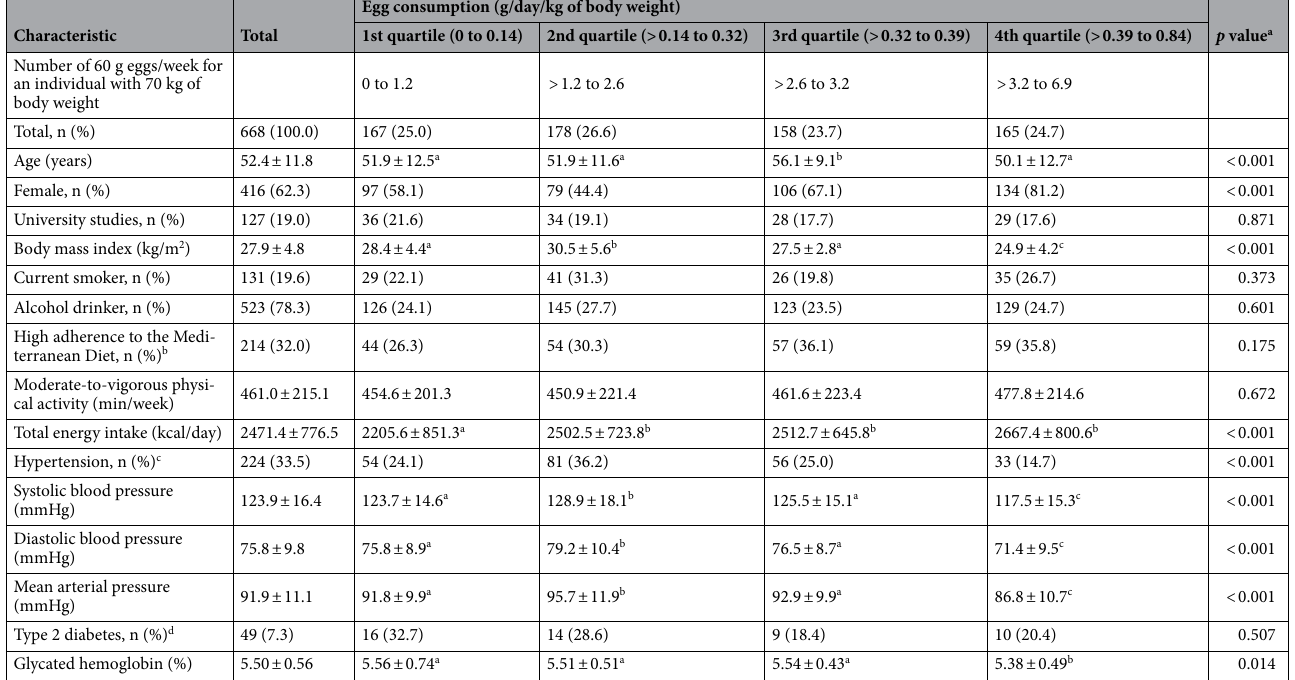
Table 1. Characteristics of the study participants by the number of eggs consumed per week per kg of body weight. Values are means ± standard deviations, except when indicated “n (%)”. a Chi-squared test for categorical variables and ANOVA for continuous variables. Different letters indicate significant differences between quartiles of egg consumption identified with the Bonferroni post hoc test. b Scores higher than 9 indicate high adherence to the Mediterranean Diet. c Systolic blood pressure ≥ 140 and/or diastolic